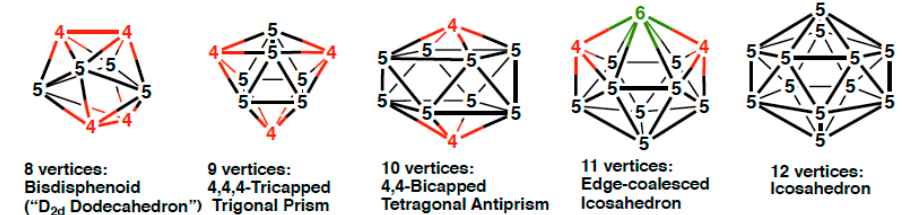
Figure 1. The most spherical ( closo ) deltahedra having from 8 to 12 vertices indicating their vertex degrees. Vertices of degree 4, 5, and 6 are also indicated in red, black, and green, respectively, in Figures 1 and 2.